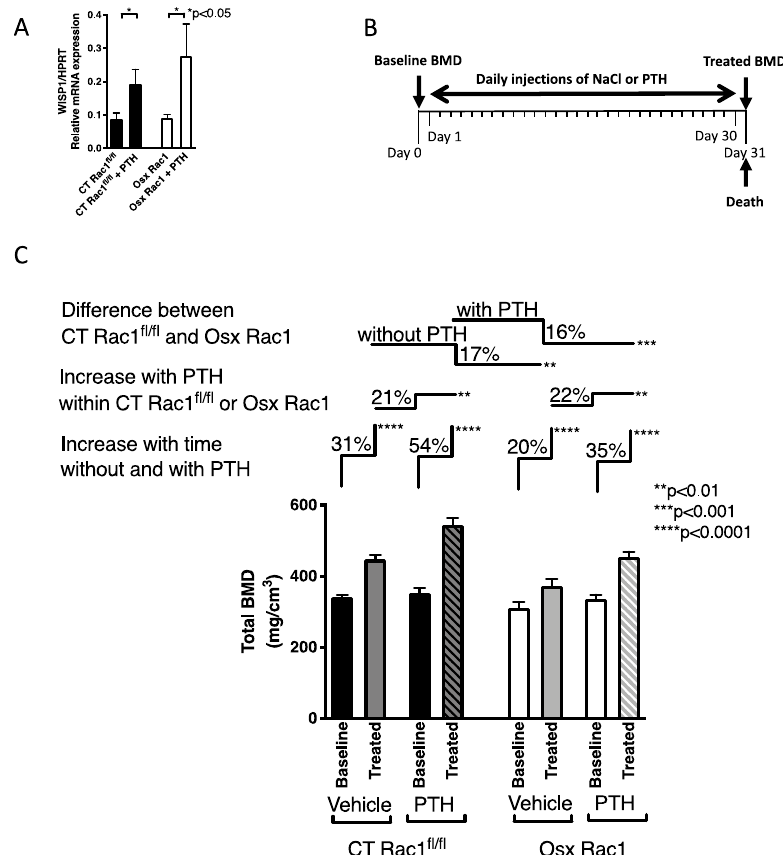
Figure 4. Rac1 is not required for mediating parathyroid hormone (PTH) anabolic effects in bone. ( A ) PTH treatment of freshly isolated osteoblasts in vitro increases WISP1 in both CT Rac1 fl/fl and Osx Rac1. N = 5/4/5/3. Data were analyzed by ANOVA ( p < 0.05) followed by unpaired t -tests. ( B ) Study design for PTH injection: at the age of 4 weeks, bone mineral density (BMD) was measured in CT Rac1 fl/fl and Osx Rac1 mice. Mice were then divided into two CT Rac1 fl/fl groups and two Osx Rac1 groups that had comparable bone mineral density (mean and range). In each genotype, the first group received daily vehicle injections and the second group daily PTH injections (80 μ g/kg/day) for 30 days. At the end of the experiment, mice were killed, and bone mineral density measured. None of the mice was exposed to doxycycline postnatally. ( C ) Treatment with daily subcutaneous PTH injection increased bone mineral density in all mice. Bone mineral density of vehicle-treated mice increased as they got older in CT Rac1 fl/fl (31%), but this increase was blunted in Osx Rac1 mice (20%). PTH increased bone mineral density in CT Rac1 fl/fl (21%) and Osx Rac1 mice (22%). Despite starting at a lower bone mineral density, Osx Rac1 mice seemed to respond adequately to age progression and to PTH, because the difference in bone density between CT Rac1 fl/fl and Osx Rac1 remained constant irrespective of whether PTH was administered or not (17 and 16%). N = 9/9, 14/14, 14/13, 22/22. Vehicle or PTH was injected daily subcutaneously in 4 weeks old mice for 30 days. Bone mineral density was measured before and after therapy. The percentages represent the increase or decrease in bone mineral density of the second value based on the first value (for the first pair: percentage change = (treated-baseline)/baseline). For statistical analysis, ANOVA was performed and found to be statistically significant with a p < 0.0001 allowing further comparisons. Each pair was evaluated either in paired t- tests (for the paired comparisons of baseline to treated group next to the label: “Increase with time without and with PTH”) or unpaired t- test (for the comparisons of treated groups together next to the labels: “Increase with PTH within CT Rac1 fl/fl or Osx Rac1” as well as “Difference between CT Rac1 fl/fl and Osx Rac1”).